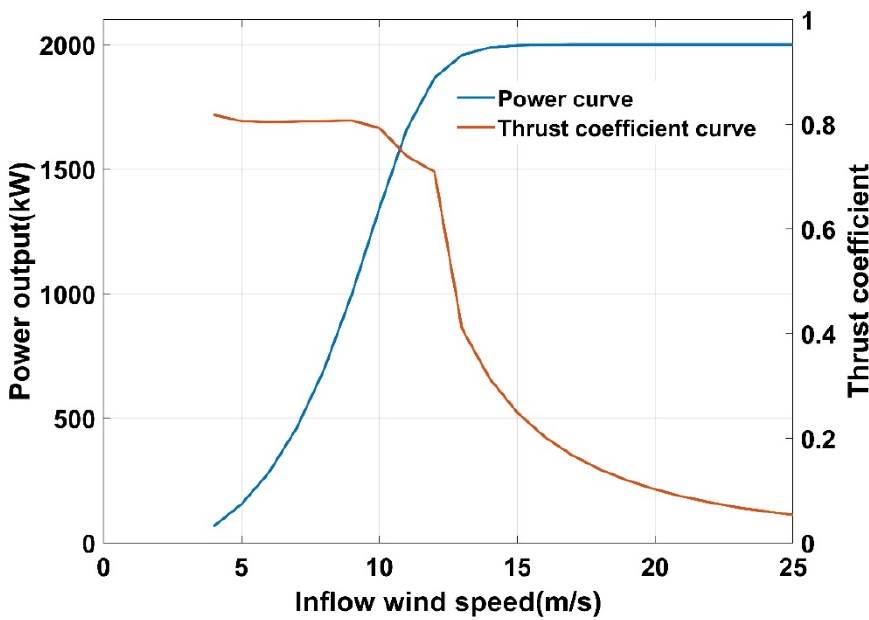
Figure 5. Power curve and thrust coefficient curve from Vestas V80 2